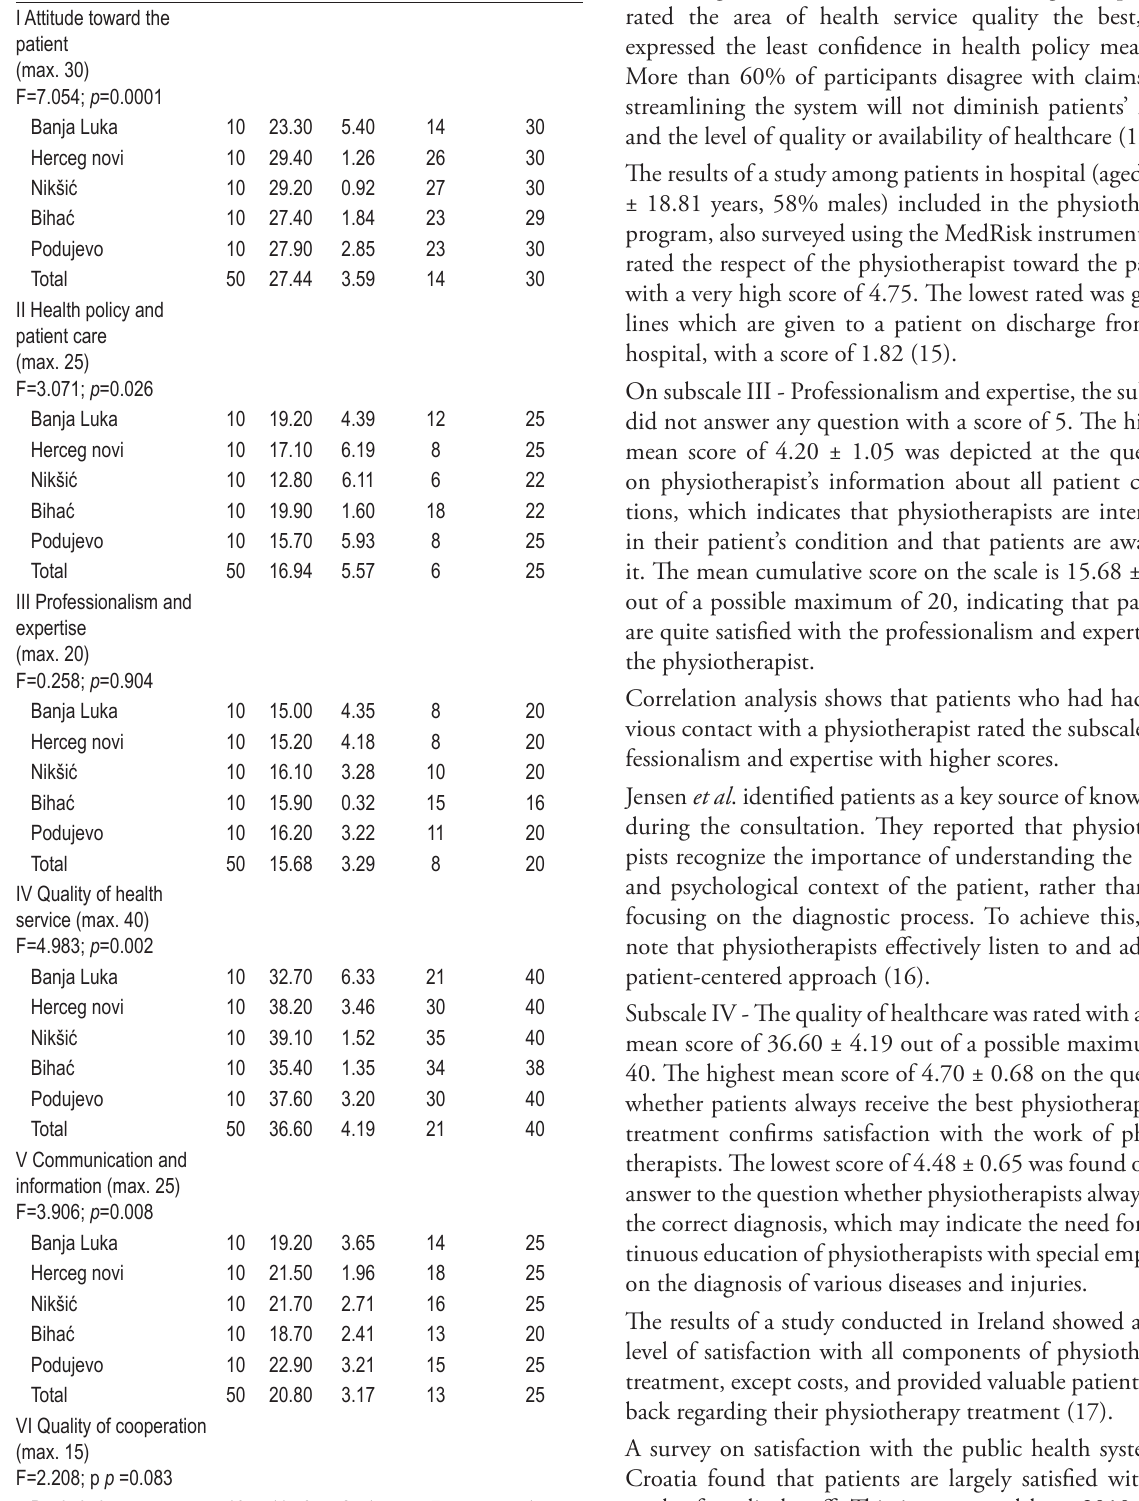
TABLE 11. Impact of place of research on fields of research Place of research n Mean SD Minimum Maximum I Attitude toward the